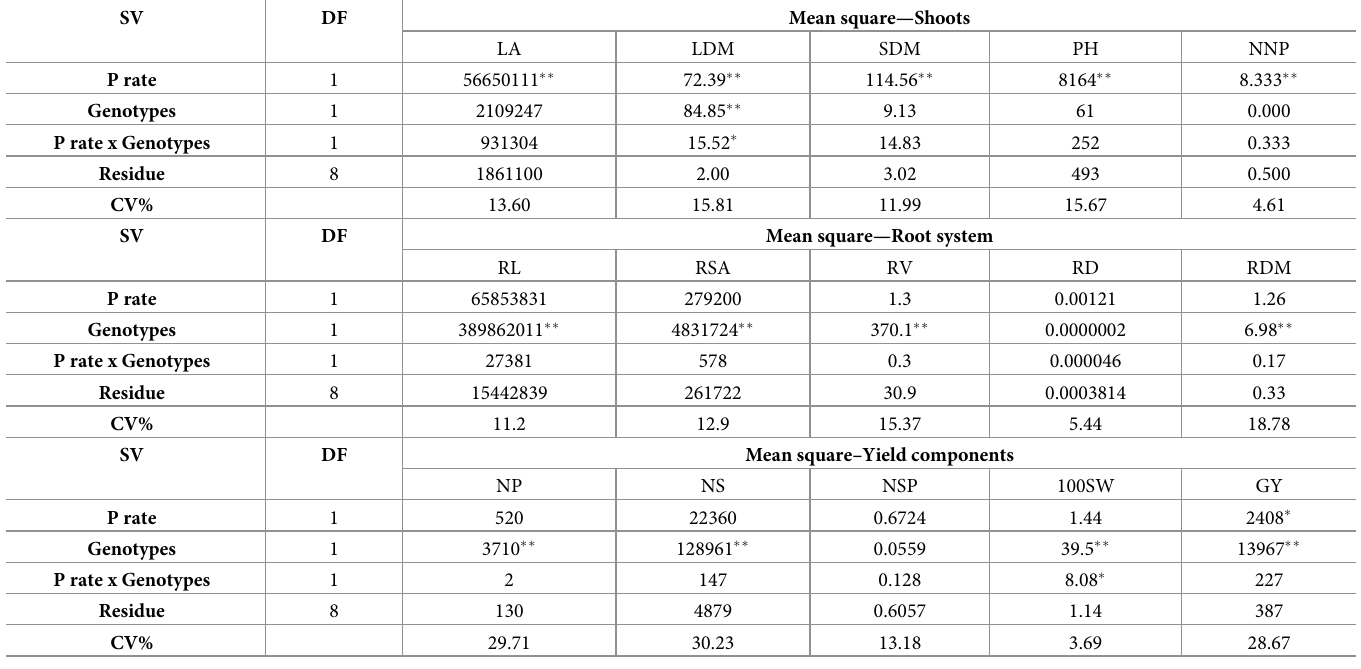
Table 1. Summary of analysis of variance of the traits related to the shoots, root system, yield components, and grain yield of the IAC Imperador and DOR 364 common bean genotypes grown hydroponically under a restrictive and control phosphorus level. SV DF P rate